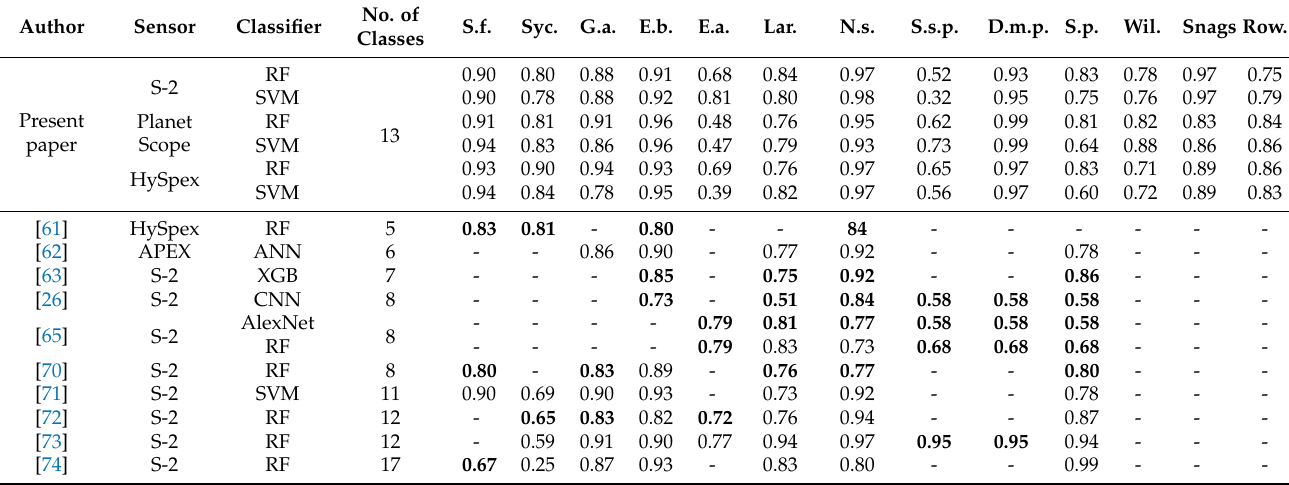
Table 6. Comparison of obtained classification results (mean F1-score) for dominant tree species with those in the literature. S.f.—silver fir ( Abies alba ); Syc.—sycamore ( Acer pseudoplatanus ); G.a.—grey alder ( Alnus incana ); E.b.—European beech ( Fagus sylvatica ); E.a.—European ash ( Fraxinus excelsior ); Lar.—larch ( Larix spp.); N.s.—Norway spruce ( Picea abies ); S.s.p.—Swiss stone pine ( Pinus cembra